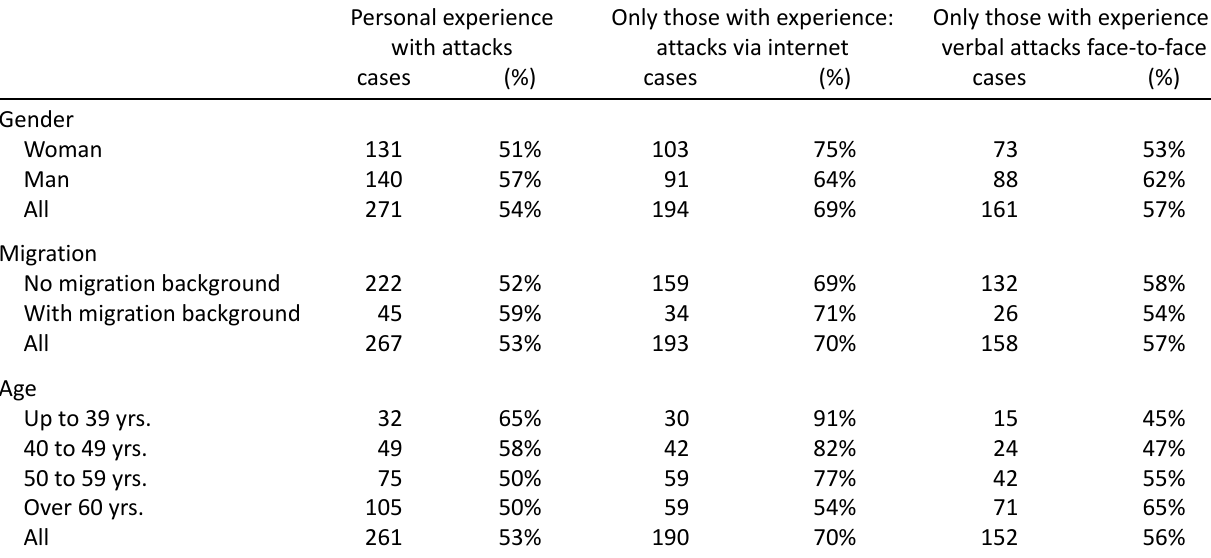
Table 2. Respondents with attack experiences. Personal experience Only those with experience: Only those with experience: with attacks attacks via